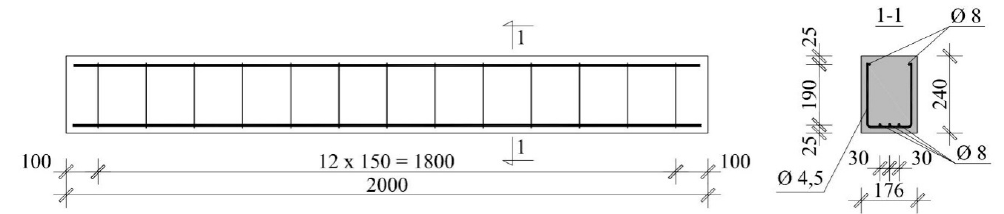
Figure 4. Dimensions and reinforcement of the tested lintel.